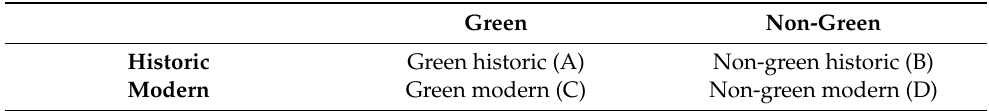
Table 2. 2 × 2 Factorial design (four